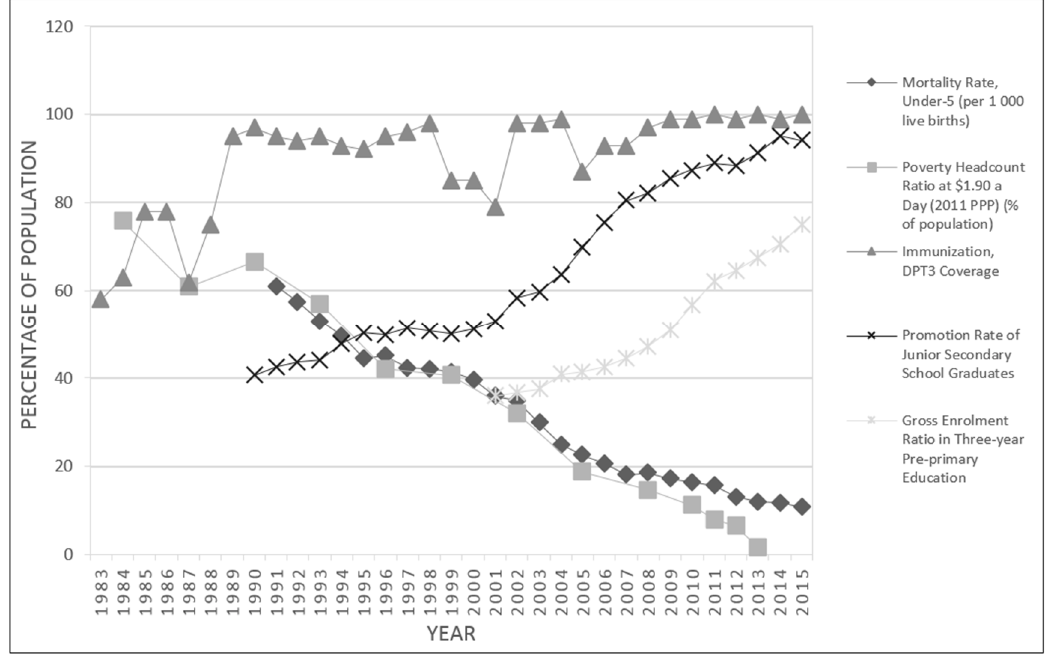
Figure 2. Child well-being trends in China. Data on mortality rate, under-5 are from National Bureau of Statistics of China [33]; Data on poverty headcount ratio at $1.90 a day are from The World Bank